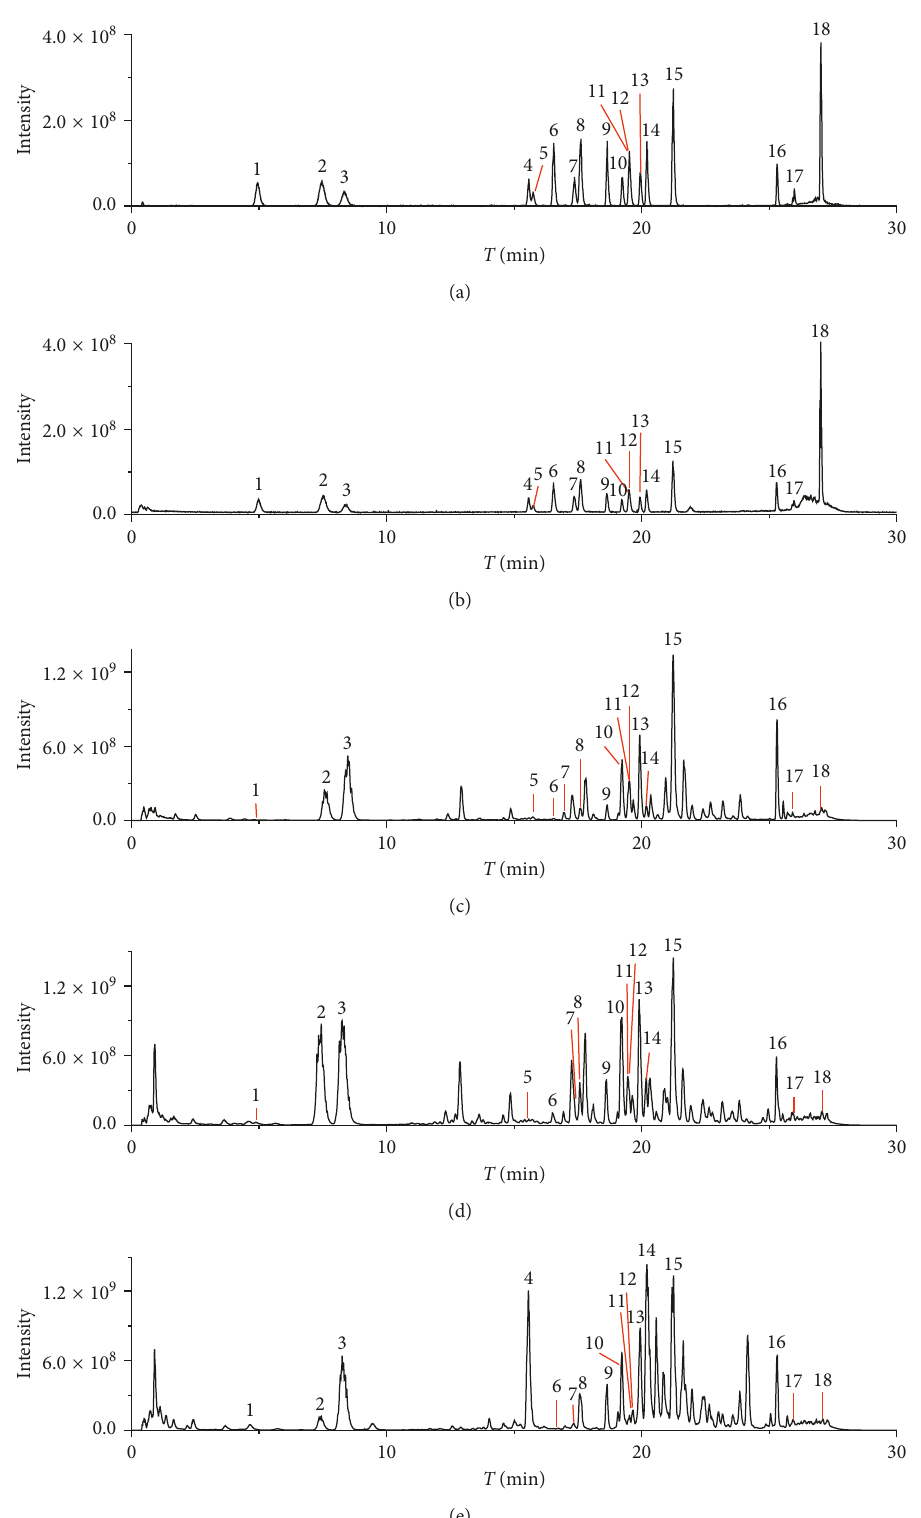
(e) ESI full scan and (b) +ESI full scan MS; Total ESI full scan MS (1 notoginsenoside R1; 2 ginsenoside Rg1; 3 − −